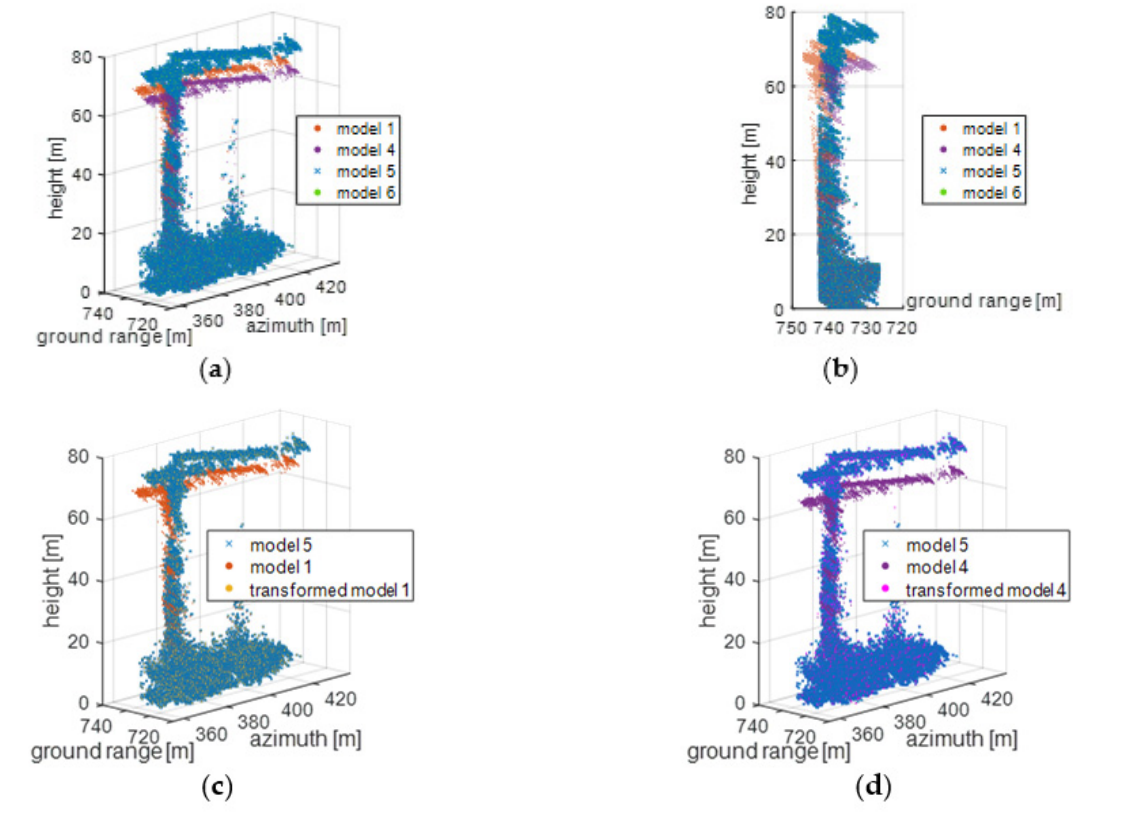
Figure 23. The reconstructed tower crane ( a ) under model 1 (the exact form of the planar wavefront model), 4 (the third approximate form of the planar wavefront model), 5 (the exact form of the spherical wavefront model) and 6 (the approximate form of the spherical wavefront model); ( b ) in the ground range–height plane; ( c ) under model 1, transformed model 1 and model 5; ( d ) under model 4, transformed model 4 and model 5.